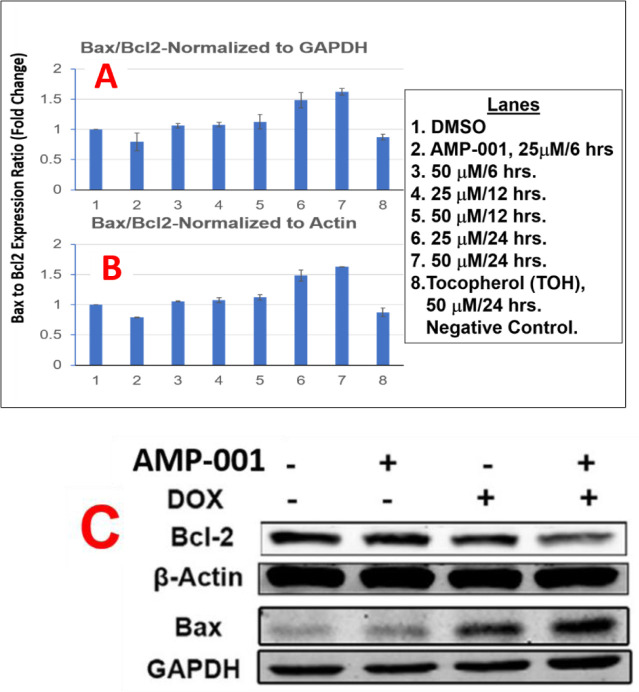
A) Quantitative Real Time RT-PCR Analysis of Ratio Bax and Bcl2 in MDA-MB-231 Cells Post Treated with AMP-001 normalized to B-Actin and B) Normalized to Actin, C) Western Blotting of Bax and Bcl2 protein released post treatment of AMP-001, Doxorubicin and combination.